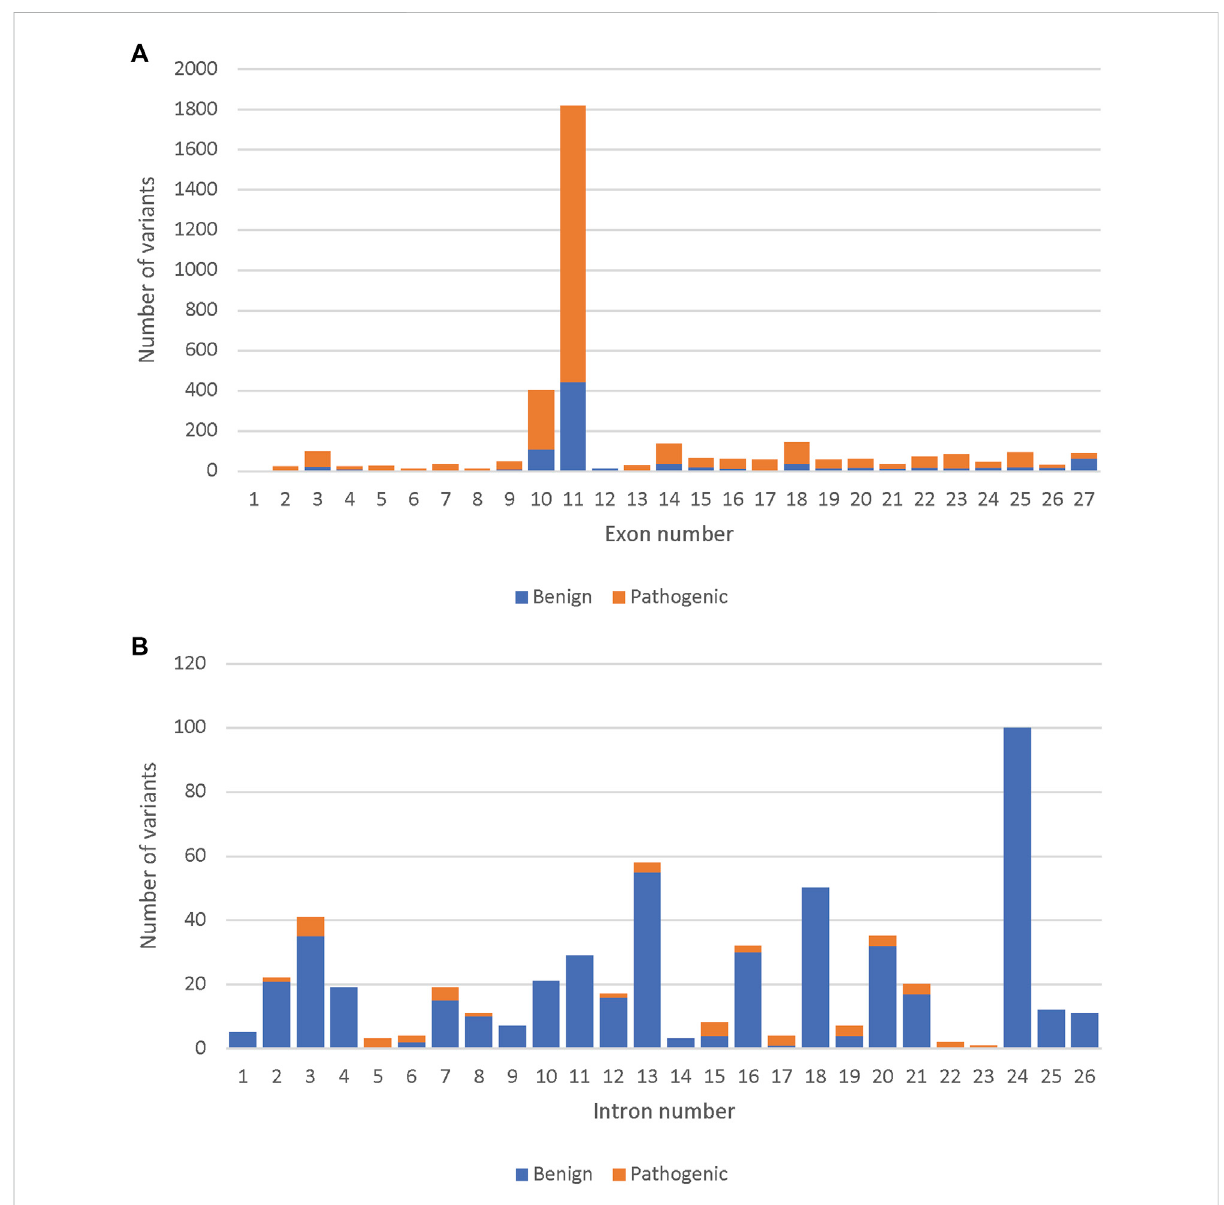
FIGURE 1 Comparison of the number of pathogenic and benign variants among the 4,102 reviewed, across the BRCA2 gene. (A) The number of pathogenic and benign variants per BRCA2 exons. (B) The number of pathogenic and benign variants per BRCA2